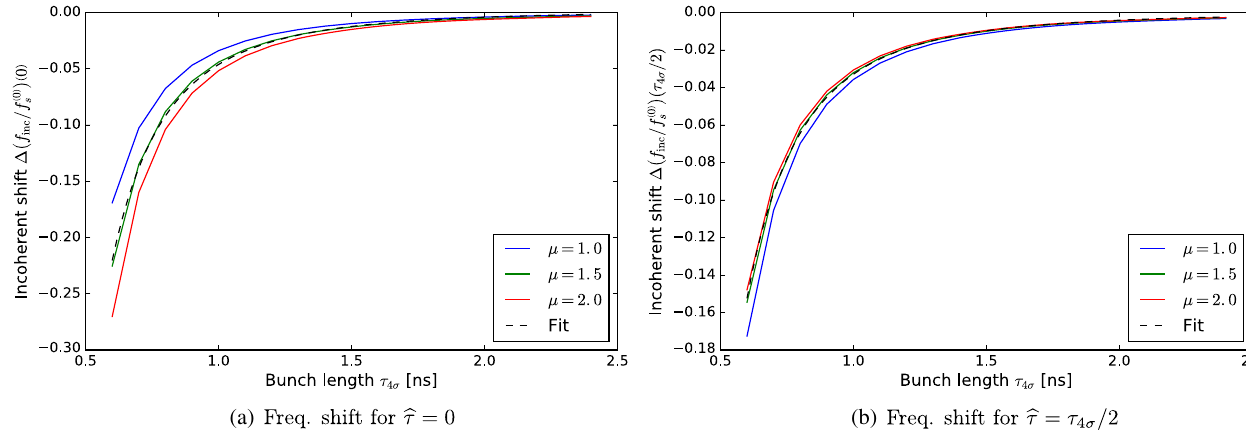
FIG. 7. The relative incoherent synchrotron frequency shift as a function of bunch length for particles with ˆ τ ≈ 0 (left) and ˆ τ ¼ τ 4 σ = 2 (right), using a pure reactive impedance Im Z =n ¼ 3 Ω and N b ¼ 5 × 10 10 ppb for the Q26 optics parameters in Table